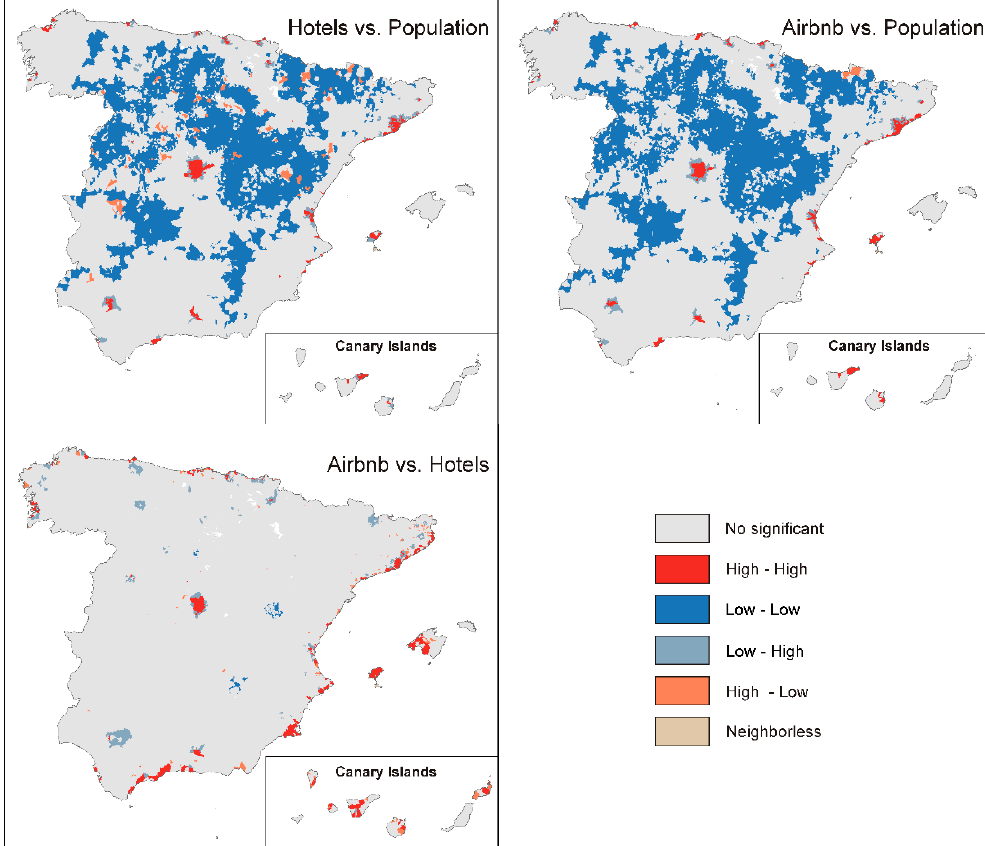
Figure 5. Cluster maps of bivariate local Moran I.